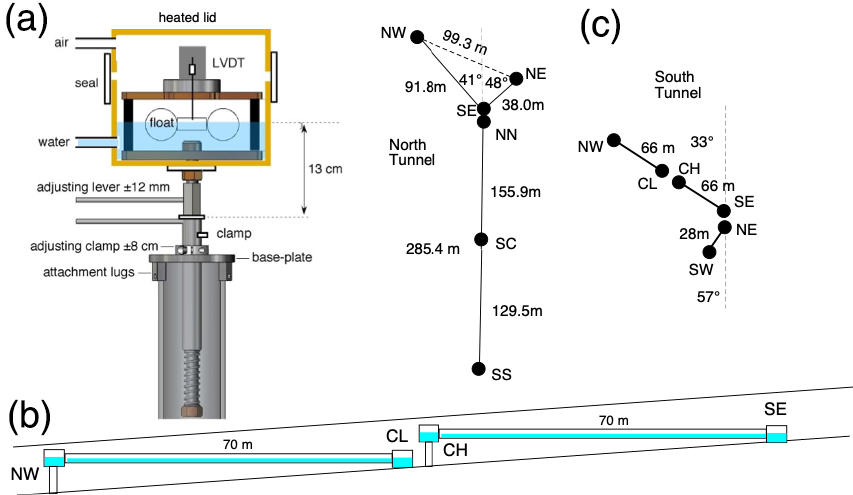
Figure 2. (a) Schematic section through water level sensor. The float is heated to inhibit condensation. (b) Michelson tiltmeter pipe installa- tion in sloping NW/SE tunnel. (c) Map view of pipe geometries in the North and South Pozzuoli tunnels. Filled circles indicate the location of water level sensors. In both tunnels co-linear tiltmeters were installed to enhance noise discrimination resulting from sub-micron thermal perturbations to water level and mounts. The calibration of each of the sensors is of the order of 1%, and since the instruments are long compared to the width of the tunnels, strain-tilt coupling is negligible.